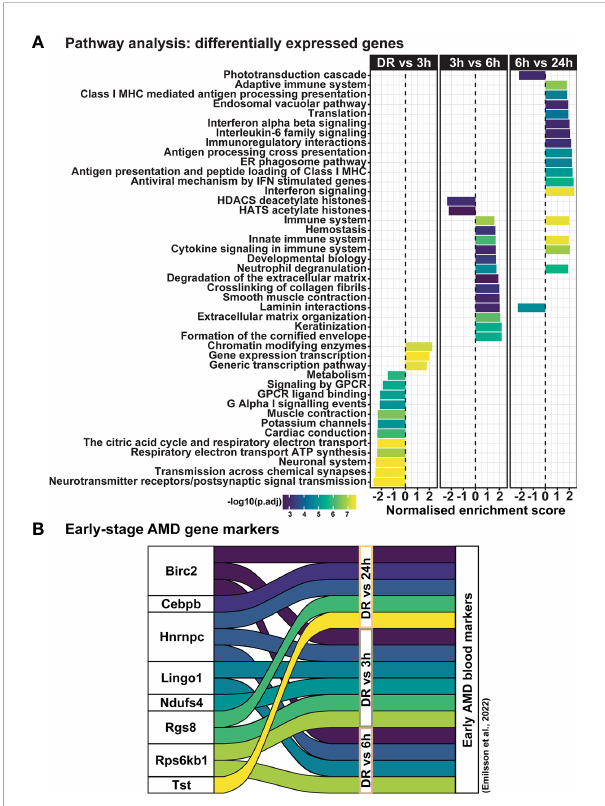
FIGURE 7 Dynamic shift in gene expression pro fi le and pathway regulation across degeneration. (A) Pathway analysis shows unique biological processes occur across degeneration, with reduced enrichment of homeostatic metabolic and signal transmission processes between DR and 3h-PD groups, but increasing enrichment of in fl ammatory pathways from 3h- PD. Decreased enrichment of phototransduction cascade pathways can also be seen between 6h-PD to 24h-PD. (B) Comparison between upregulated early-stage AMD biomarkers in patient serum and in early time-course model of retinal degeneration shows overlapping markers. Signi fi cance p < 0.05 , n=4